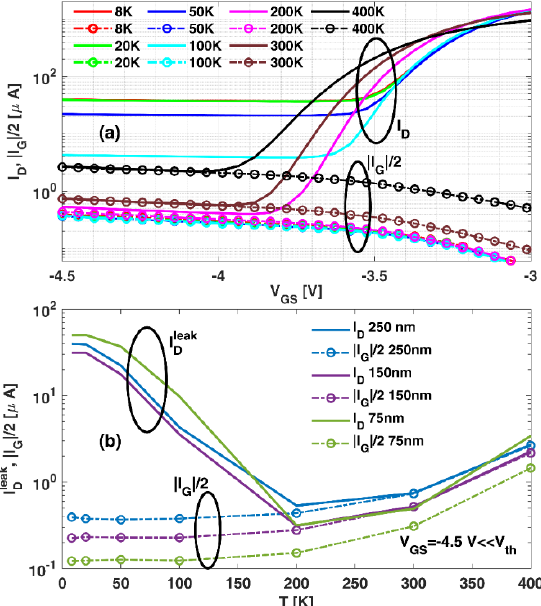
Figure 6. 𝐼 𝐷𝑙𝑒𝑎𝑘 and | I G |/2 at 𝑉 𝐷𝑆 = 0.1 V ( a ) as a function of 𝑉 𝐺𝑆 measured at different T for the case Figure 6. I leak and | I G |/2 at V DS = 0.1 V ( a ) as a function of V GS measured at different T for the case D of the transistor with L g = 250 nm and ( b ) as a function of T for 𝑉 𝐺𝑆 = −4.5 V for the three transistors of the transistor with L g = 250 nm and ( b ) as a function of T for V GS = − 4.5 V for the three transistors under test. under